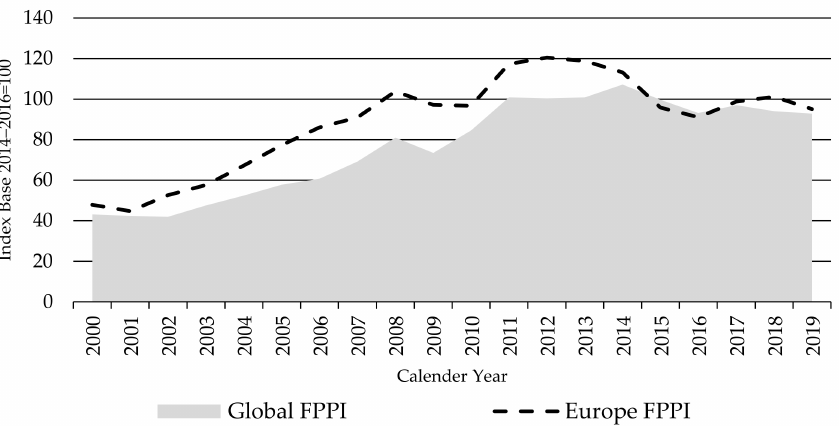
Figure 5. The Global and Europe Finished Cattle Producer Price Indices FPPIs, source: own